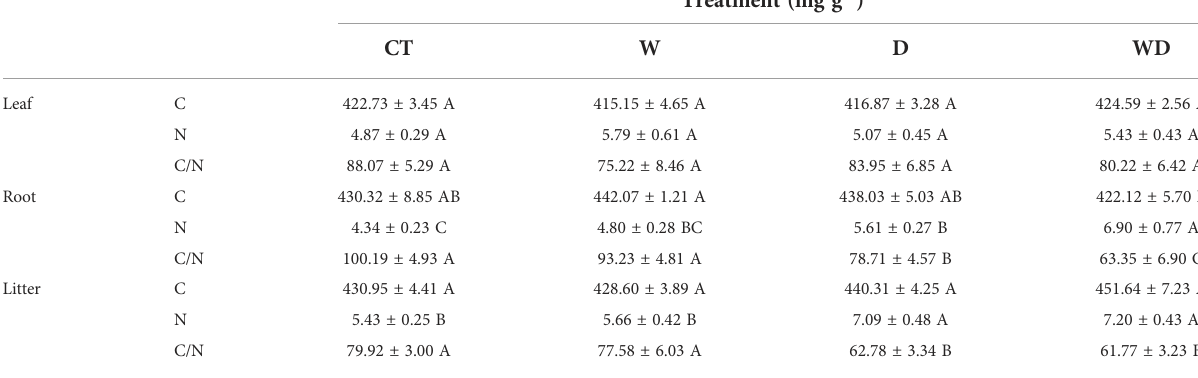
TABLE 2 C and N concentrations and C/N ratios in leaves, roots, and litter of C. lanceolata .